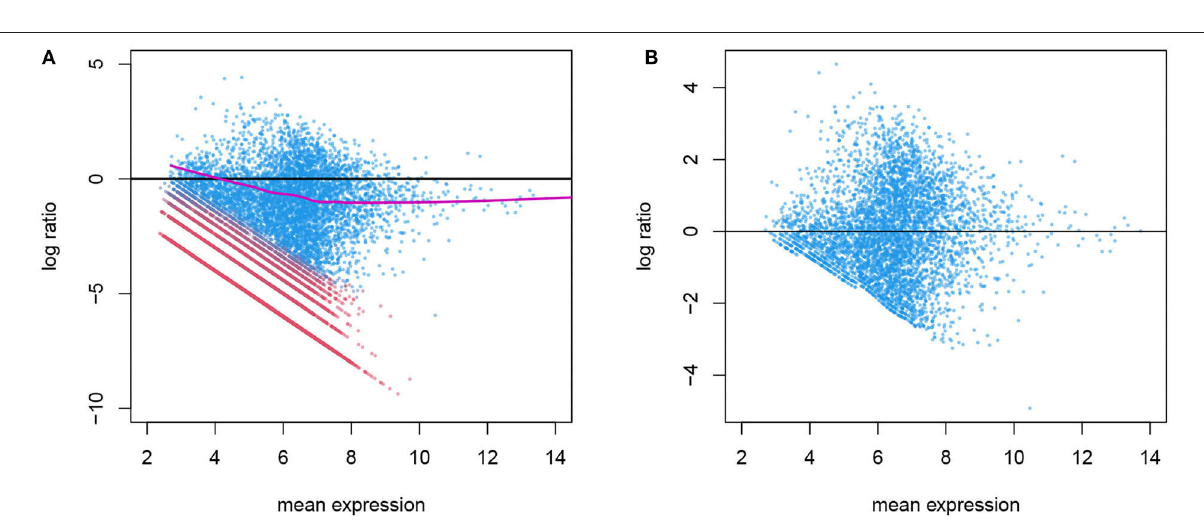
FIGURE 3 | (A) Before normalization MA plot for gene counts before normalization. The log ratio of a gene’s count in one cell over its mean expression level is plotted against the log mean expression (the alpha cells in the T2D data are used here). Genes in active expression phase are shown in blue and genes in background phase shown in red. Only the blue genes are used in estimating the systematic bias, shown in purple. (B) After normalization: the log ratio from normalized genes in the active phase shows no systematic